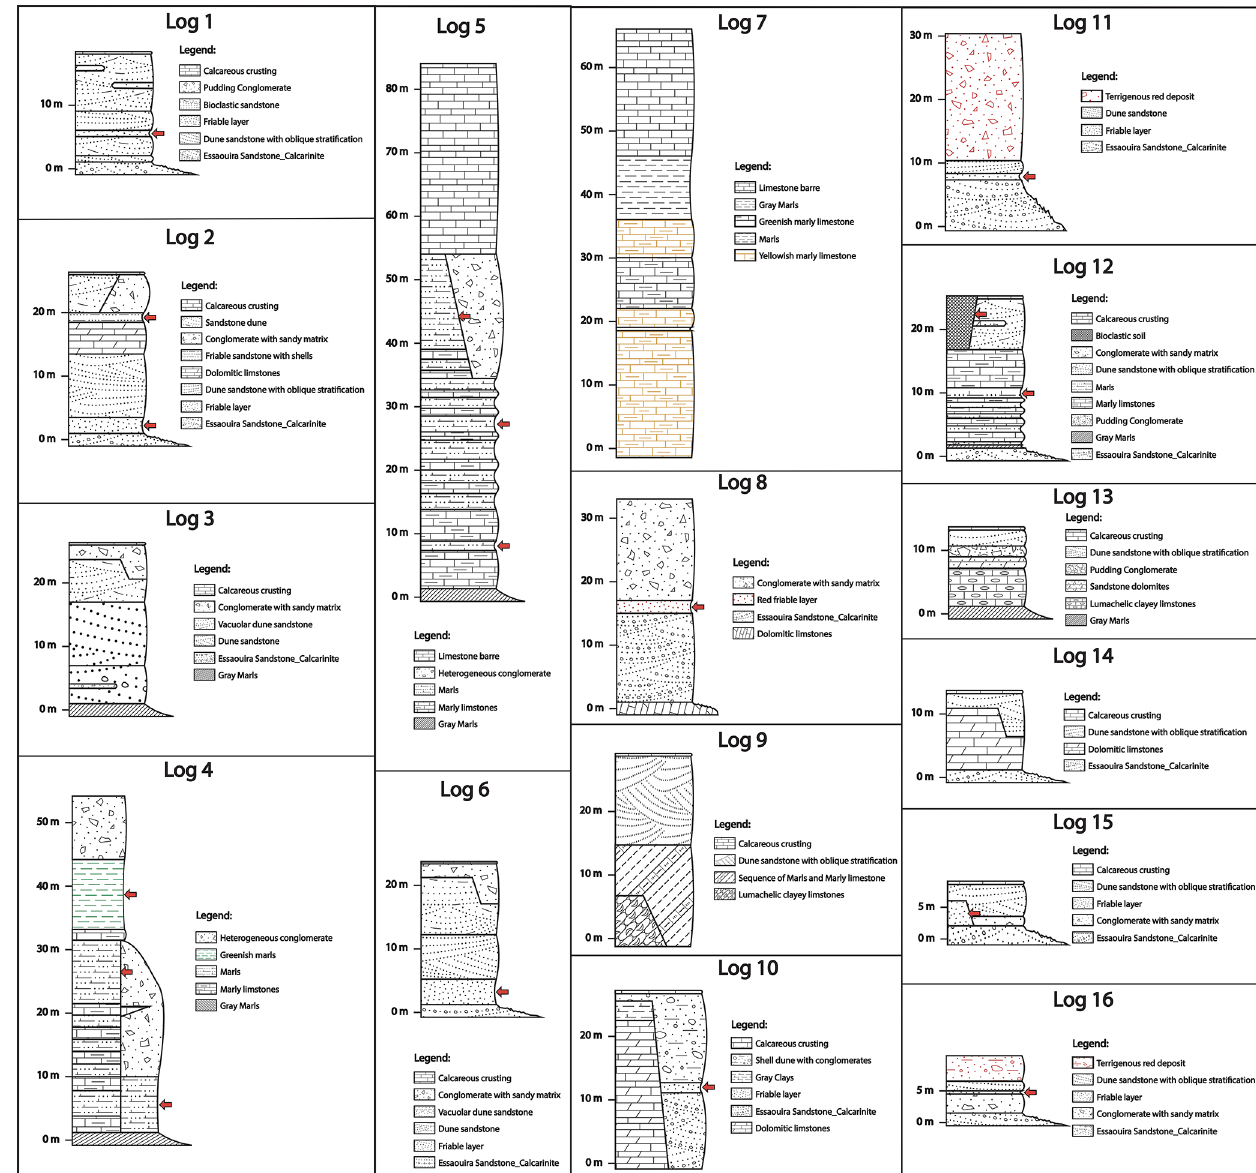
Figure 6. Stratigraphic columns for the Essaouira coastal